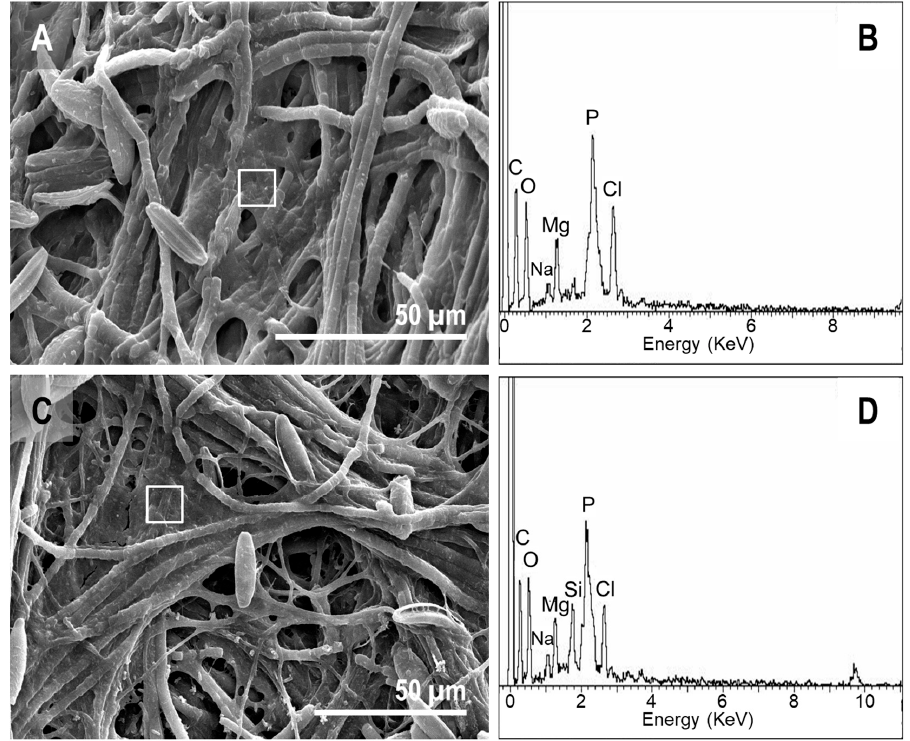
Figure 9. SEM-EDXS images of the precipitates on the upper side of the ferns in mats. ( A ) At day 7, the cyanobacterial filaments and diatoms as well as mineral precipitates were present. ( B , C ) EDXS spectra recorded at the areas highlighted in ( A ). ( D , F ) Precipitates that occurred over the mat in the impression left by the fern and their corresponding EDXS spectra of the spot highlighted in the image ( E , G , and H respectively). ( I , L ) Precipitates over ferns in mats at day 60 and the corresponding EDXS spectra ( J , K , and M respectively).